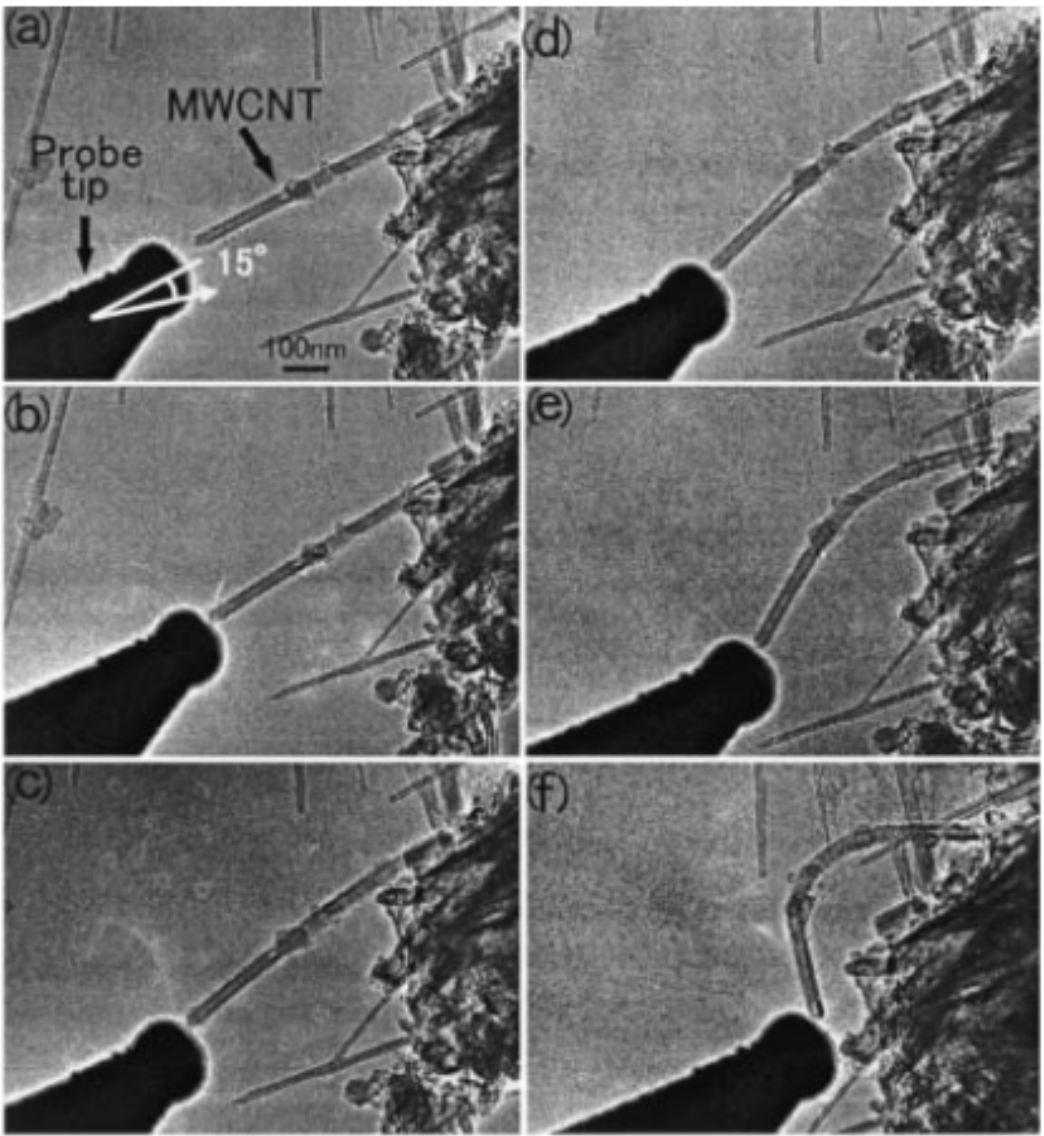
Figure 2. ( a )–( f ) Series of TEM images of deformation processes for MWNTs initiated by applying compressive force in the sample direction; ( g ) Force–displacement diagram. The points indicated by arrows correspond to the TEM images in ( d ) and ( e ). Reprinted from Reference